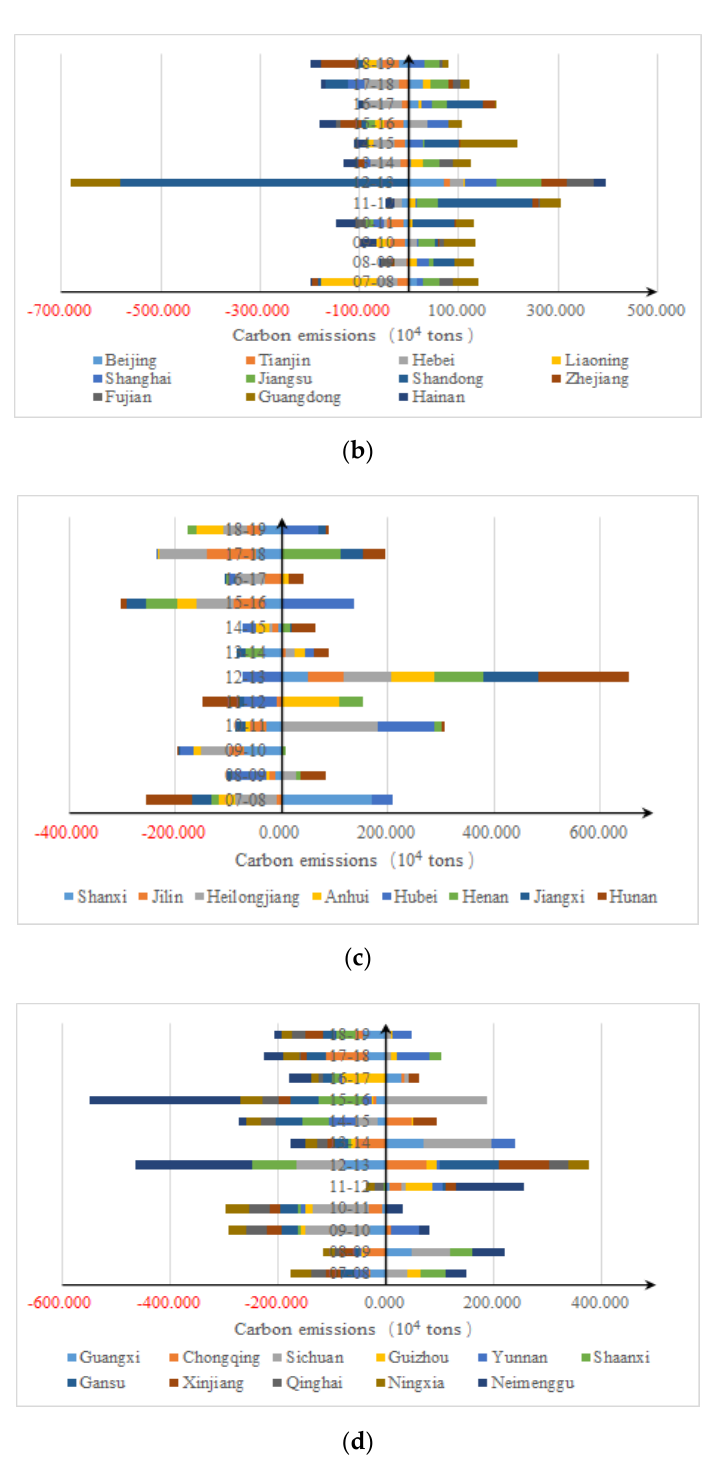
Figure 4. The catch-up effect of carbon emissions in logistics at the regional level during 2007–2019. ( a ). The catch-up effect at regional level; ( b ). the catch-up effect of eastern regions; ( c ). the catch-up effect of central regions; ( d ). the catch-up effect of western regions. According to Figure 4a, the average value of CUE in eastern, central, and western regions was − 6 thousand tons, 19 thousand tons, and − 87 thousand tons respectively, indicating that the eastern and western regions caught up to the benchmark, while the central region lagged behind the benchmark in carbon emission reduction of logistics. The